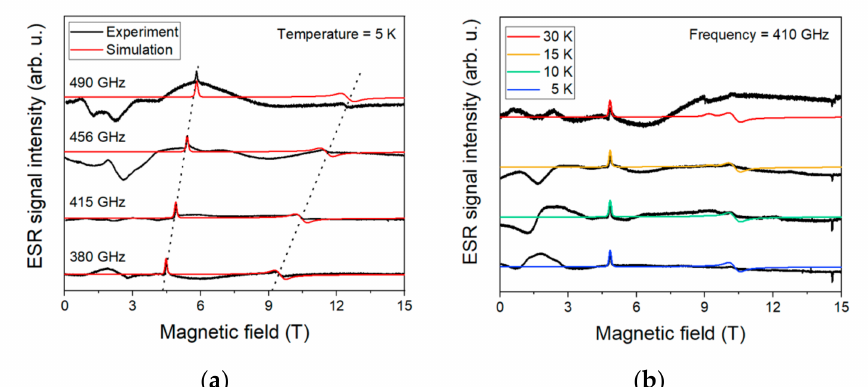
Figure 8. ( a )—high-frequency electron spin resonance (HF-ESR) spectra for four di ff erent frequencies at 5 K. The dotted line is guidance for Zeeman splitting. ( b )—temperature dependence acquired at 410 GHz. Black line in both is experimental, and red / colored line is the simulation.